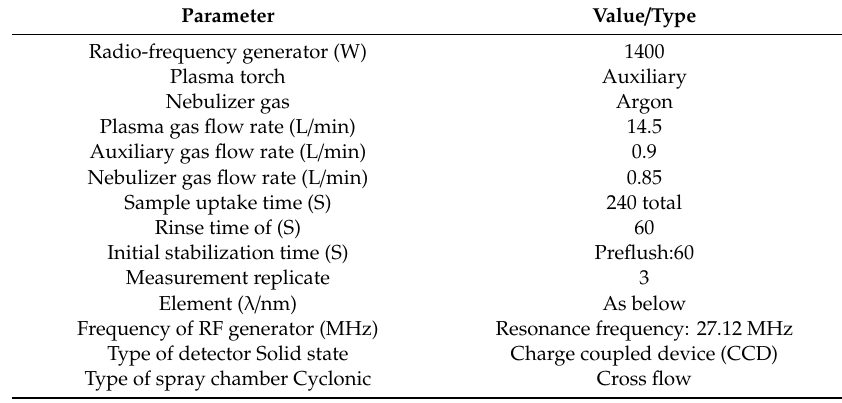
Table 1. Inductively coupled plasma–optical emission spectrometry (ICP-OES) instrumental and operational parameters for metal determination.